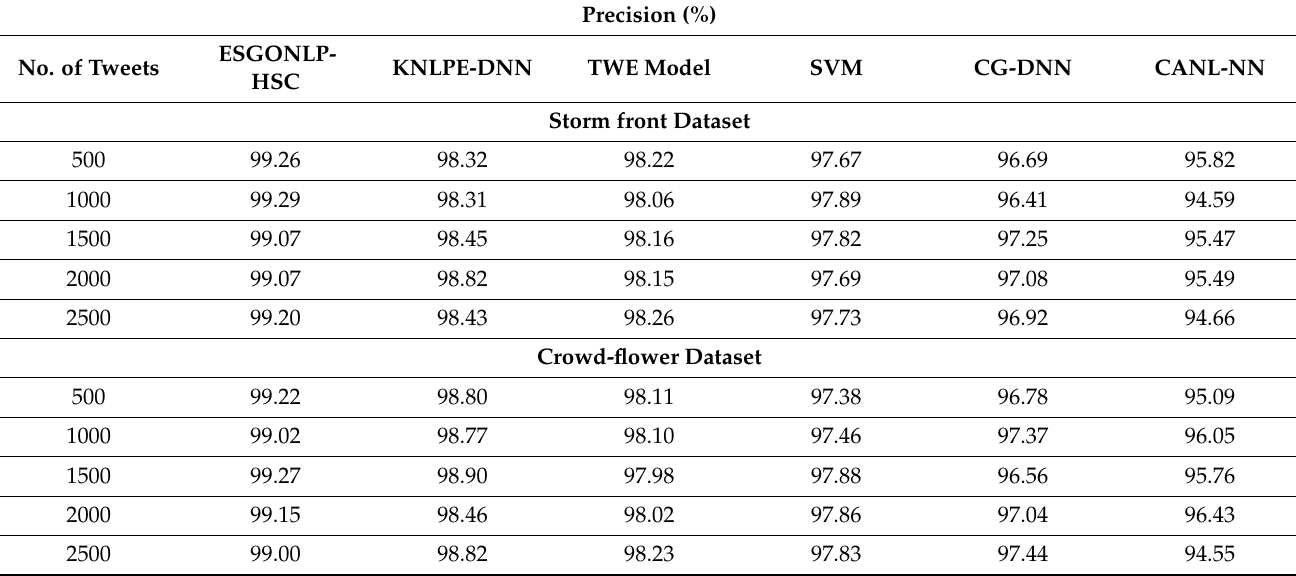
Table 3. Precision analysis of ESGONLP-HSC method with existing approach under Storm front and Crowd-flower datasets.